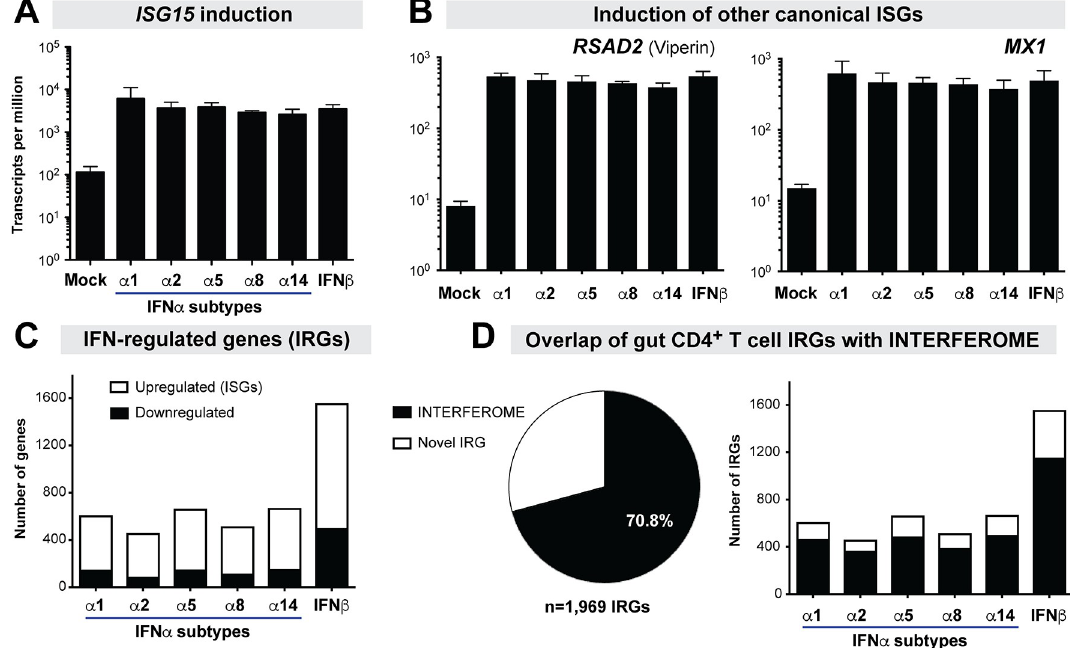
Fig 3. Identification of Novel IRGs. LPMCs (n = 3 donors) were stimulated with IFN α subtypes and IFN β normalized to ISG15 ISRE-activity and the transcriptomes were evaluated at 18 h via RNAseq. Sequences were compared against annotated Ensembl genes (version GRCh38). IRGs were defined based on a 1.5-fold change and an FDR cut-off of 20% relative to mock. Induction of (A) ISG15 and (B) RSAD2 and MX1 by IFN-Is based on the RNAseq data. (C) Number of upregulated versus downregulated IRGs. (D) Overlap of gut CD4+ T cell ‘interferomes’ with published IRGs in the INTERFEROME database 2.0 [5].